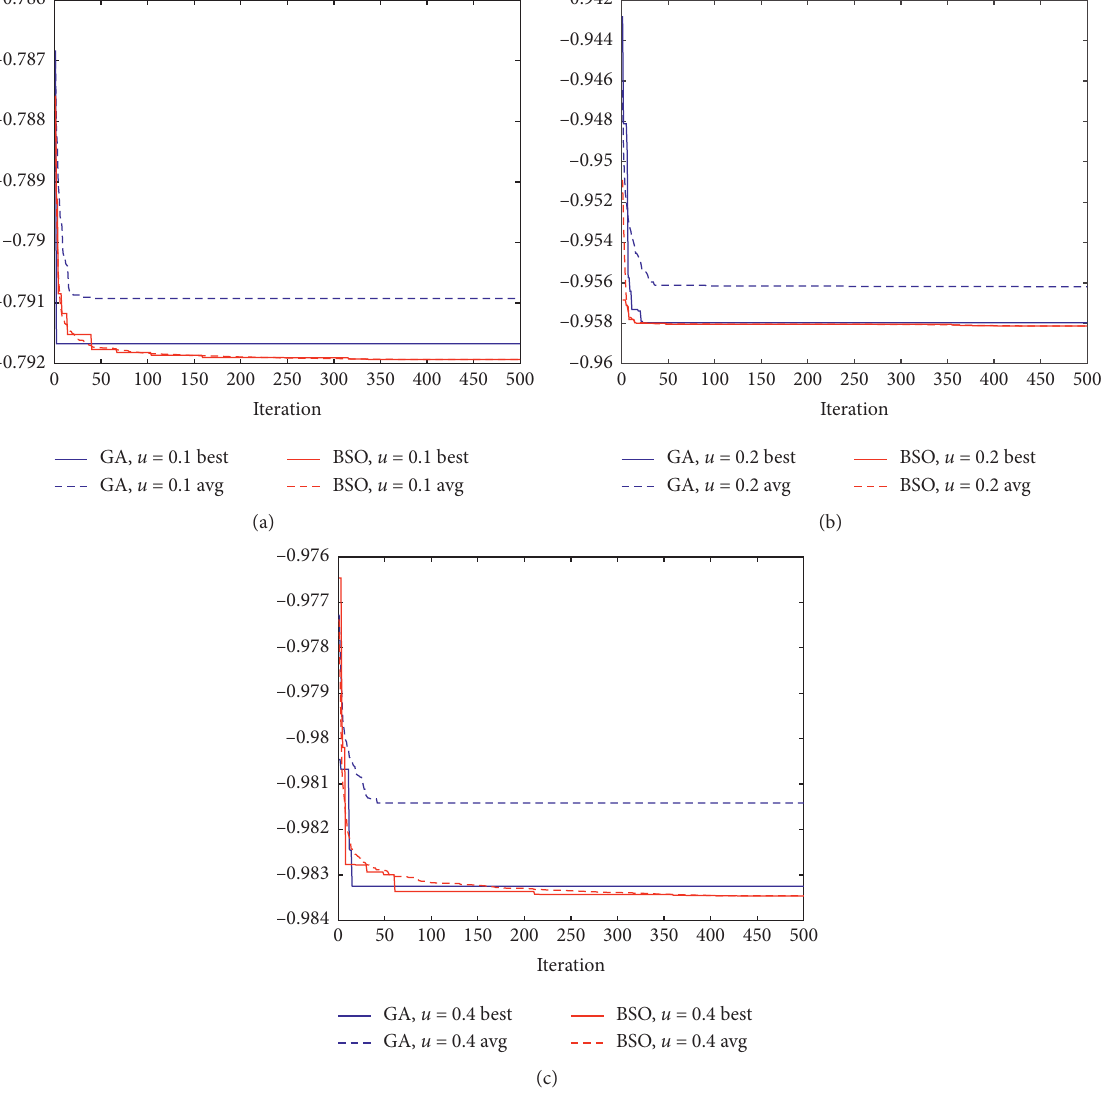
Figure 4: Comparative study on fitness: (a) u � 0.1; (b) u � 0.2; (c) u � 0.4.